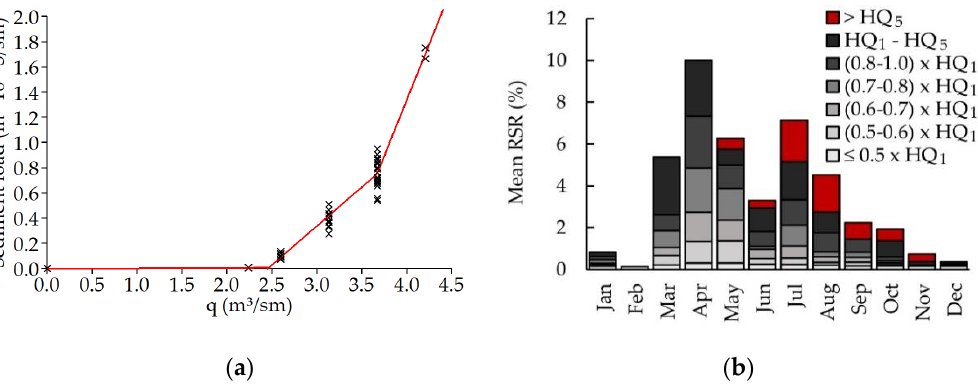
Figure 4. Incoming sediment load and reservoir sedimentation rate RSR, ( a ) tri-linear sediment load model; ( b ) monthly RSR distribution for different discharge ranges based on ( a ).